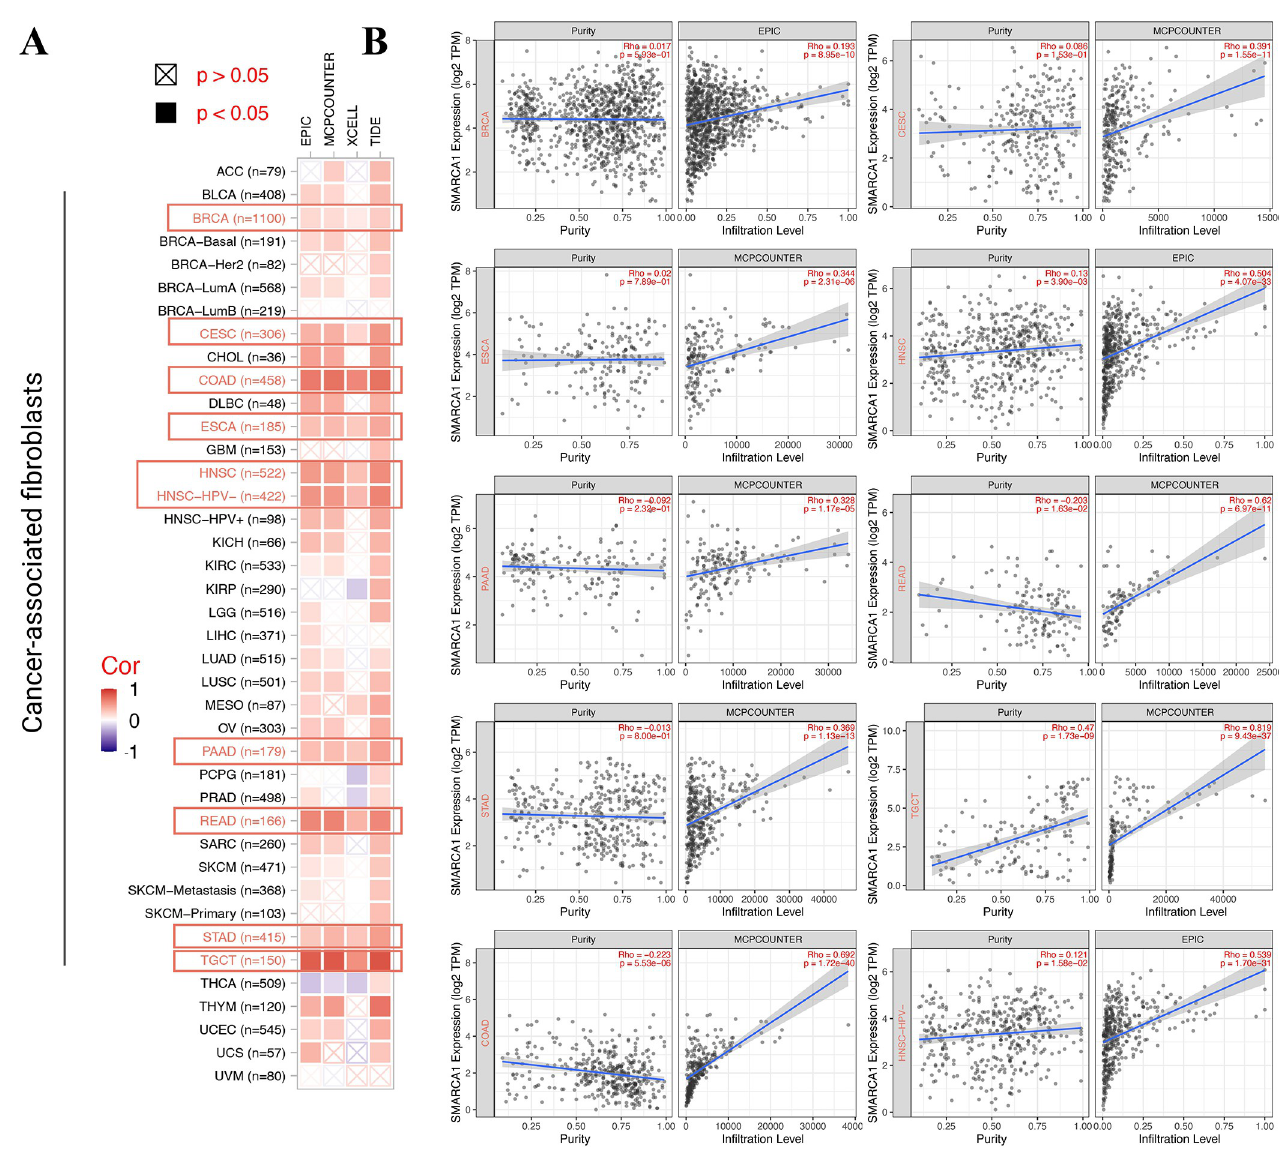
Fig 10. Correlation analysis between SMARCA1 expression and cancer-associated fibroblasts. (A) Heatmap of correlation between SMARCA1 and the tumor-related immune infiltration level of cancer-associated fibroblasts among all cancers in TCGA with diverse of algorithms; (B) correlation analysis of BRCA, CESC, COAD, ESCA, HNSC, HNSC-HPV, PAAD, READ, STAD and TGCT.